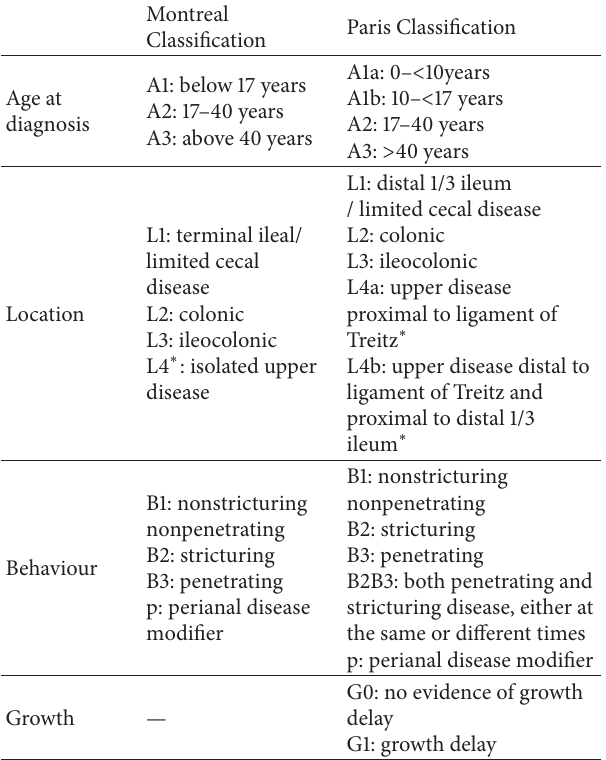
Table 2: Comparison of Montreal and Paris Classifications for Crohn’s disease based on Levine et al.